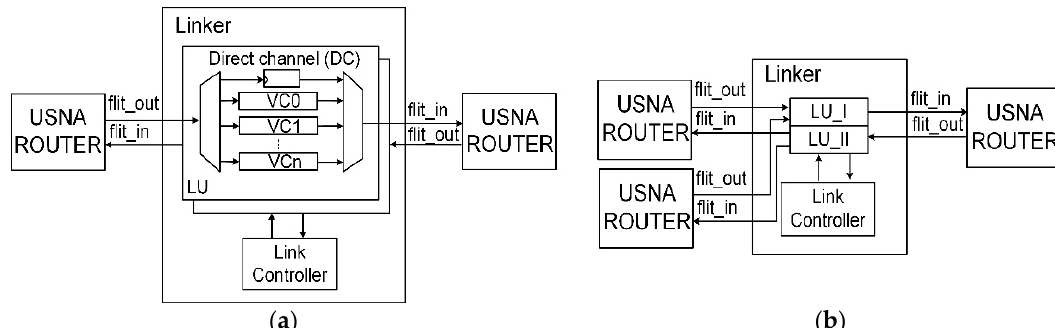
Figure 4. USNA linkers ( a ) with two ports and ( b ) three ports.